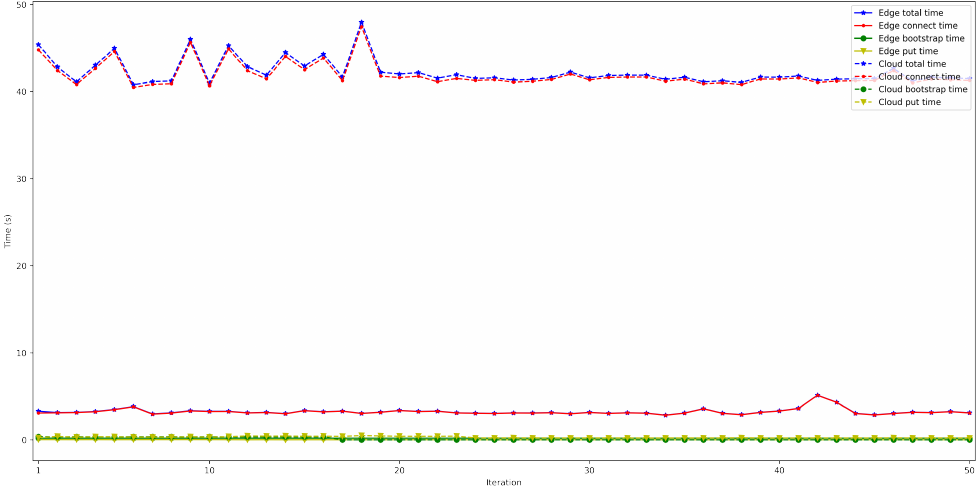
Figure 11. Latency when running the bootstrap node in the edge/Cloud for 300 connected peers.